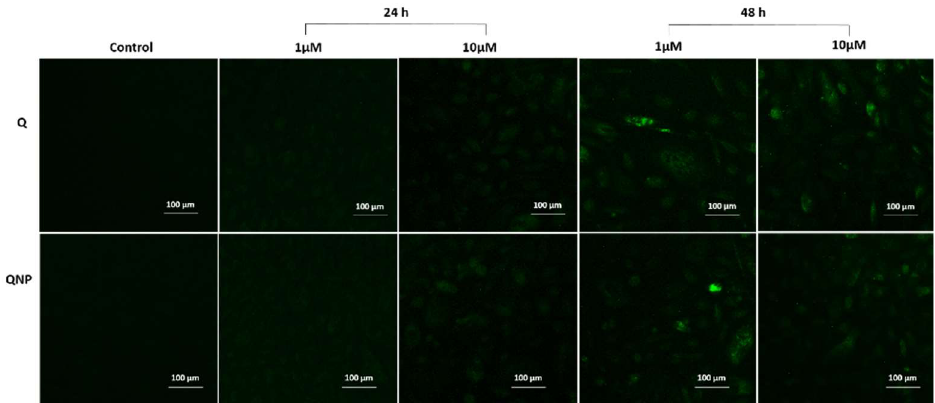
Figure 8. Fluorescence micrographs of FLICA caspase 3 and 7-stained HeLa cells treated with 1 µM and 10 µM concentrations of Q or QNPs for 24 and 48 h.